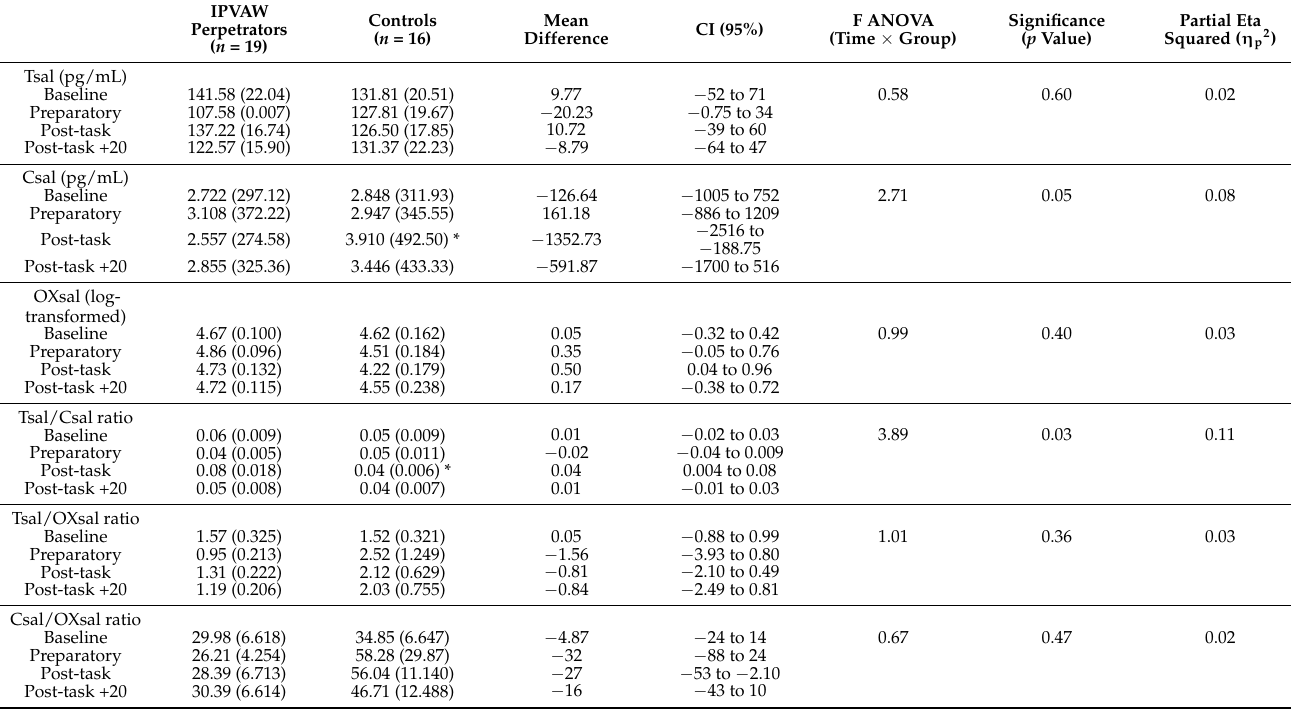
Table 2. Means and Standard Error of the Mean for Hormones in Each Group.